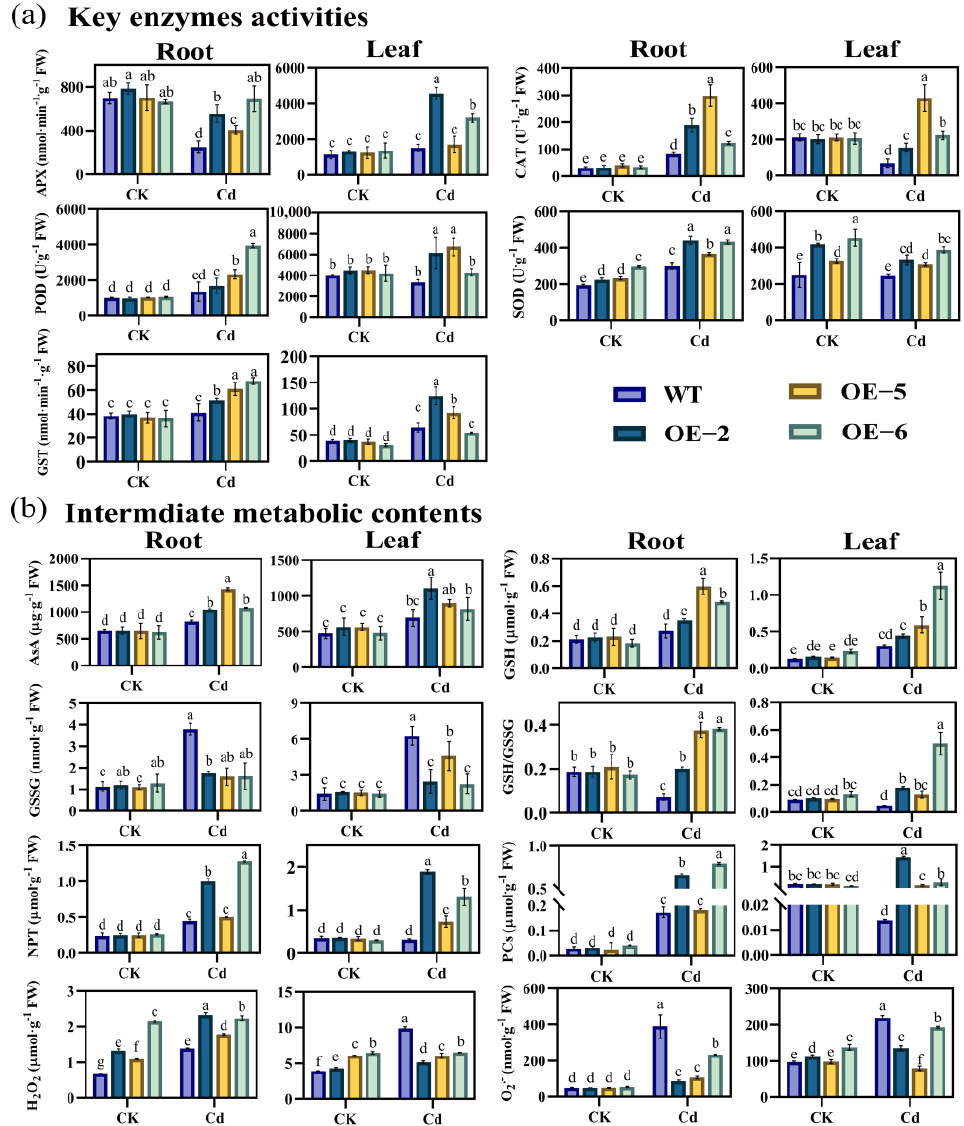
Figure 4. Ascorbate (AsA)–glutathione (GSH) metabolomic pathway in transgenic poplars and WT. ( a ) Expression level of key enzymes activities; ( b ) content of intermediate metabolites associated with the AsA–GSH metabolomic pathway in SpHsfA4c- transgenic poplars and WT under Cd stress for 30 d. CK: 0 μM CdCl 2 treatment; Cd: 100 μM CdCl 2 treatment. Data are presented as means ± SD. Different letters above the bars represent significant differences at p < 0.05.